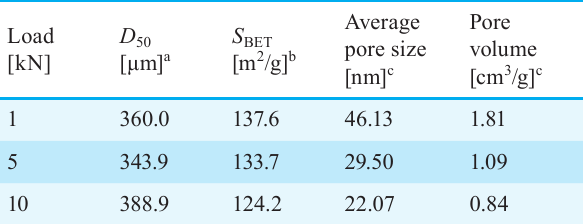
Table 3 Fundamental data of the model aggregates prepared at 1, 5, and 10 kN.